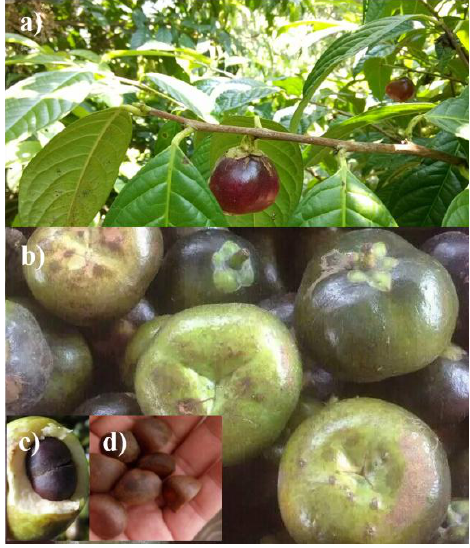
Figure 1. Photos of Camellia nitidissima Chi: a ; b ) fruit; c ) fruit flesh; and d ) seeds.